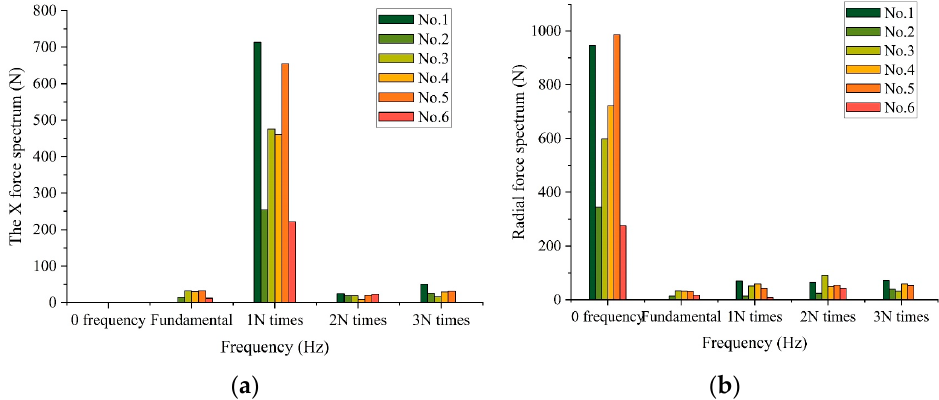
Figure 11. Frequency spectrum analysis of milling cutting load. ( a ) Force in X-direction. ( b ) Resultant force in radial direction.